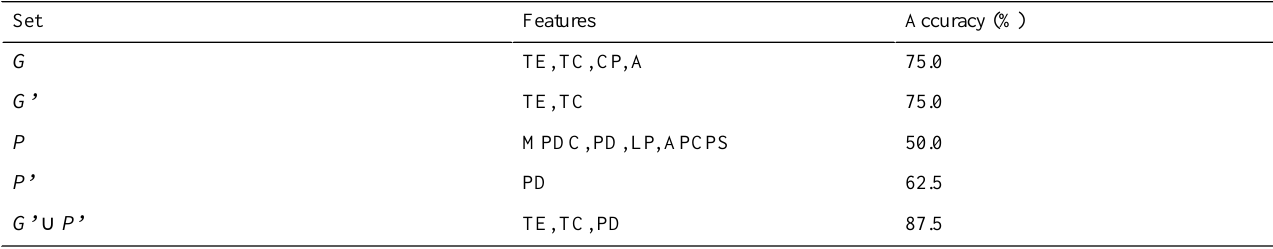
Table 5. Results for a random forest classifier using different sets of